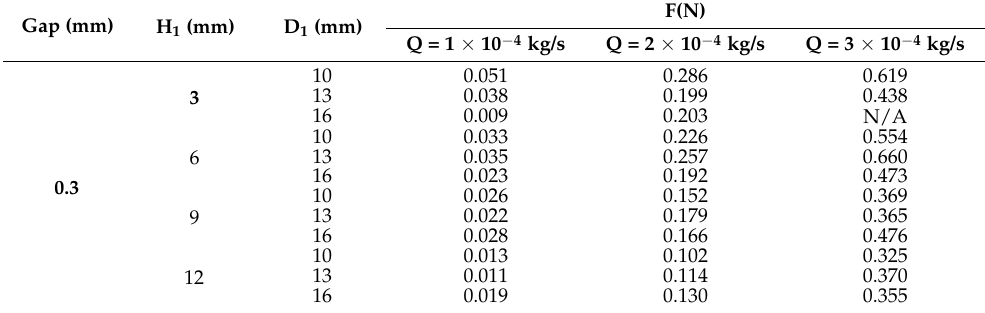
Table 2. Parameters and suction force.